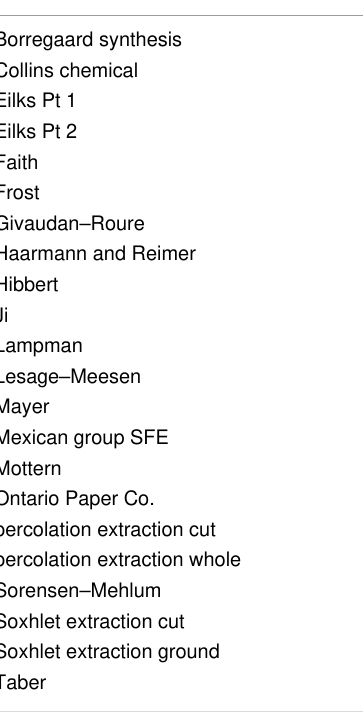
Table 6: Summary of Borda count and poset dominance analysis of 22 synthesis plans for vanillin listed alphabetically. Alphabetized list of vanillin synthesis plans